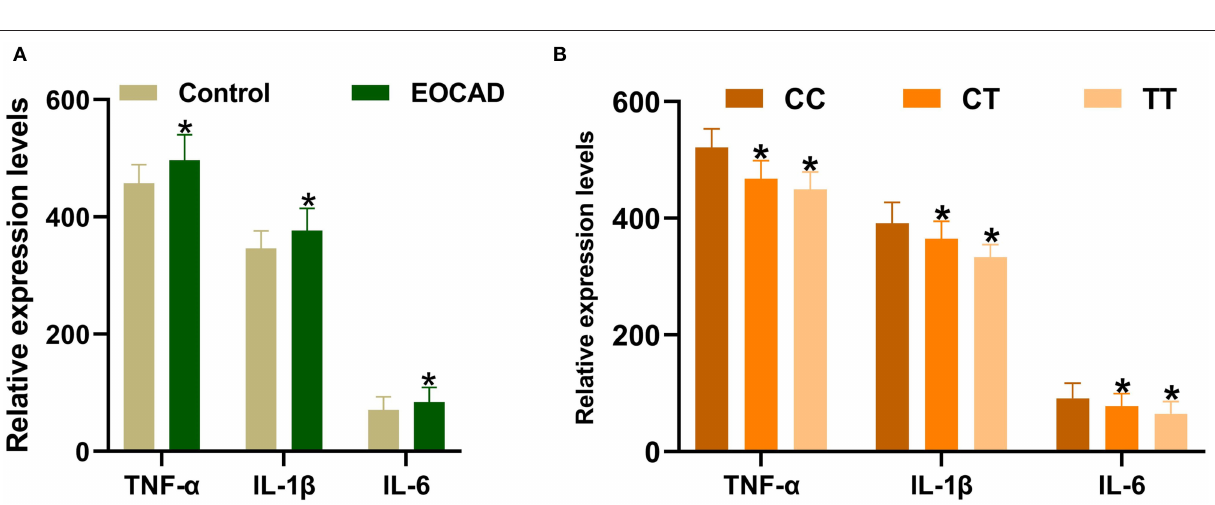
FIGURE 5 | Expression levels of TNF- α , IL-1 β , and IL-6 in the control and EOCAD groups. (A) Significantly higher expression levels of TNF- α , IL-1 β , and IL-6 were detected in the EOCAD group than in the control group. (B) The rs3737787T allele carriers maintained lower levels of TNF- α , IL-1 β , and IL-6 than T non-carriers. USF1 , upstream transcription factor 1; EOCAD, early-onset coronary artery disease; TNF- α , tumor necrosis factor- α ; IL-1 β , interleukin 1 β ; IL-6, interleukin 6. * p <